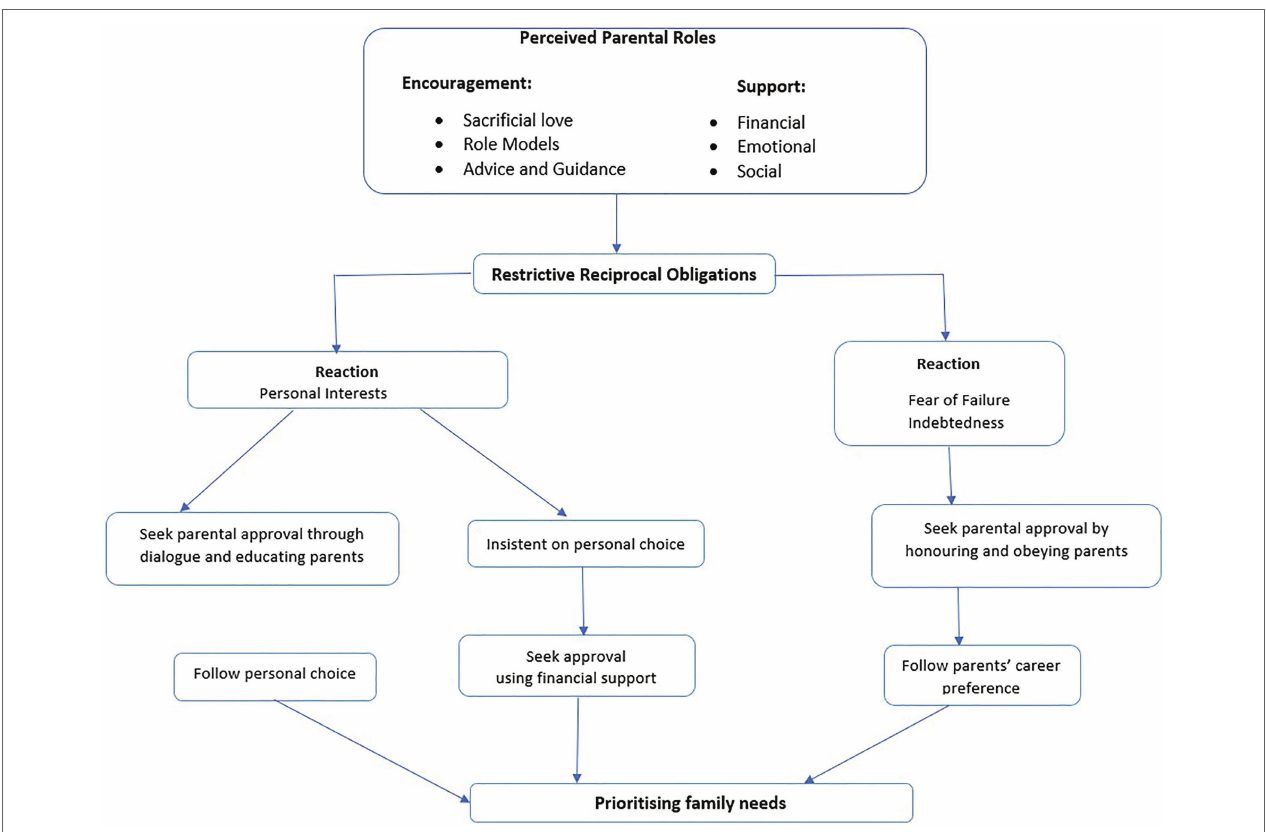
FIGURE 2 | Model of sub-Saharan African (SSA) migrant youths’ perceptions of parental roles in their career decision making